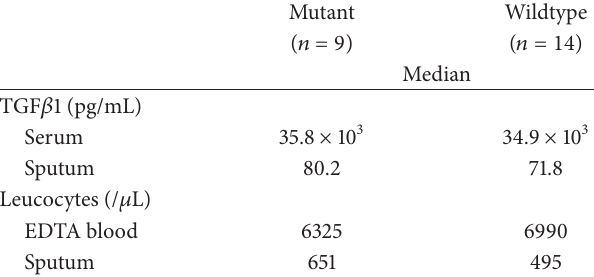
Table 6: TGF 𝛽 1 variant − 509C/T. TGF 𝛽 1 and leucocytes.